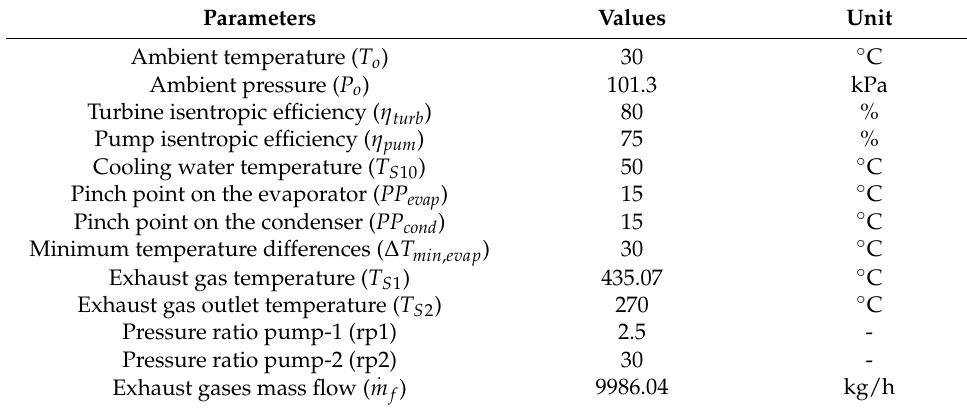
Table 6. Main conditions for the simulation [62].